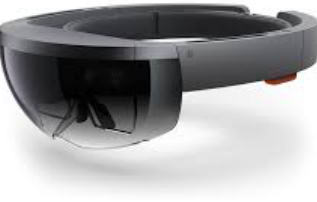
Figure 3. Popular mixed-reality device (MRD): Microsoft HoloLens